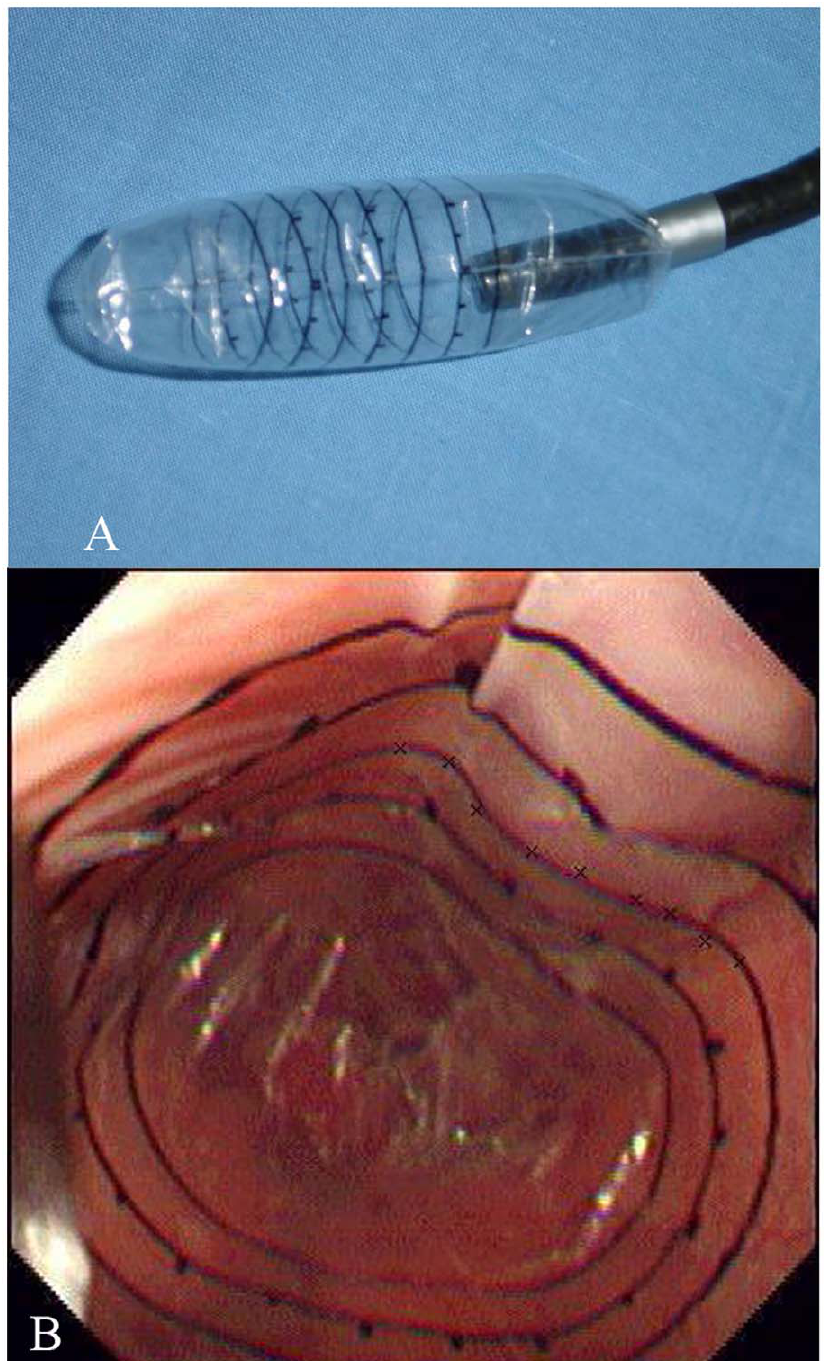
Figure 3. Transparent balloon fixed at the tip of endoscope. a The circular lines on the balloon were used as the variceal markers to monitor varix flatting. The scales in the lines (5-mm intervals) were used to estimate the variceal size. b Variceal markers highlighted the regular curve of the underlying varices.